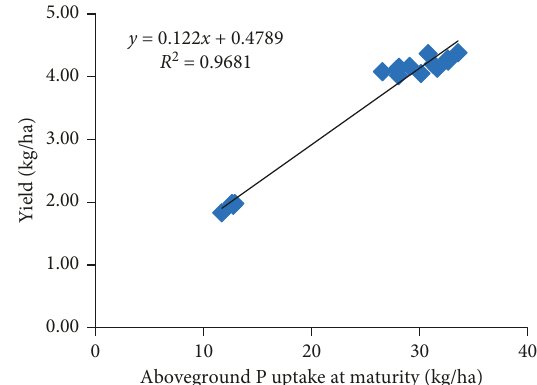
Figure 3: Relationship between the grain yields and total above- ground P at maturity across all